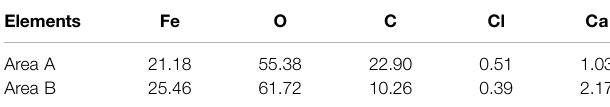
TABLE 4 | Elemental distribution in inner scale on N80 steel corrosion under CO 2 - O 2 condition (at%).